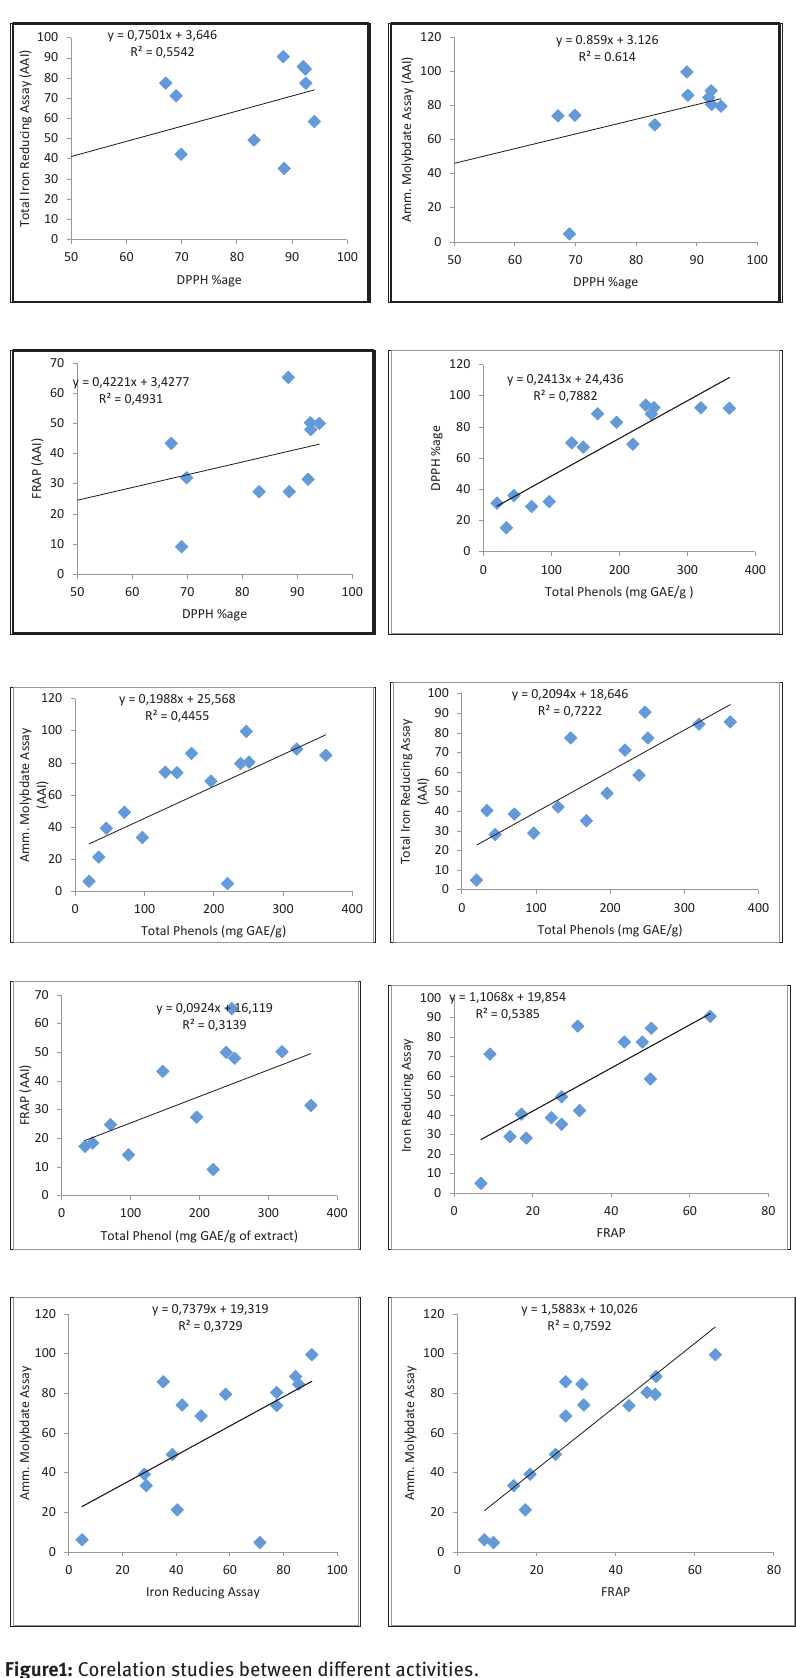
Figure1: Corelation studies between different